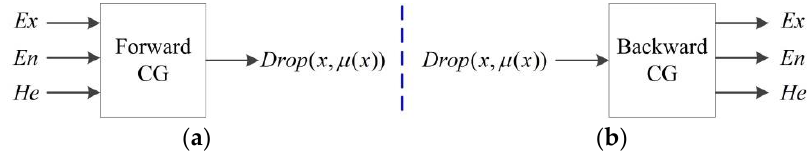
Figure 4. Schematic diagram of cloud generator (CG). ( a ) Forward CG; ( b ) backward CG.